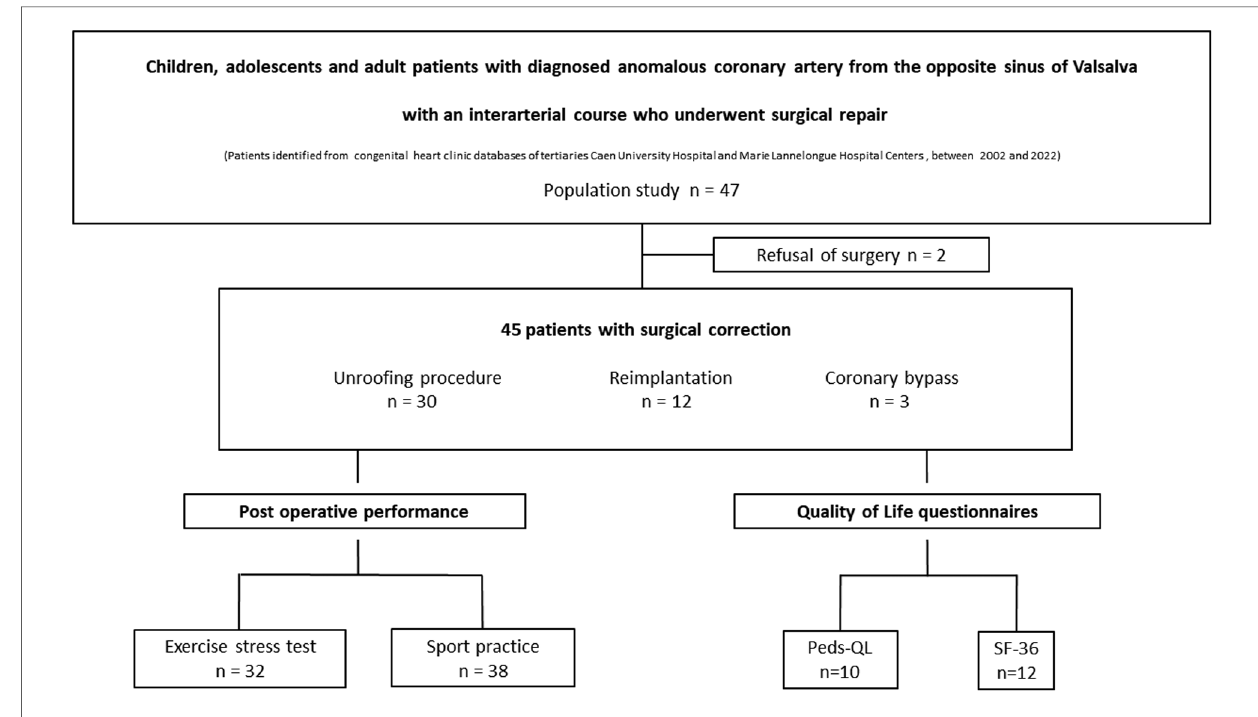
FIGURE 2 Study fl ow chart.